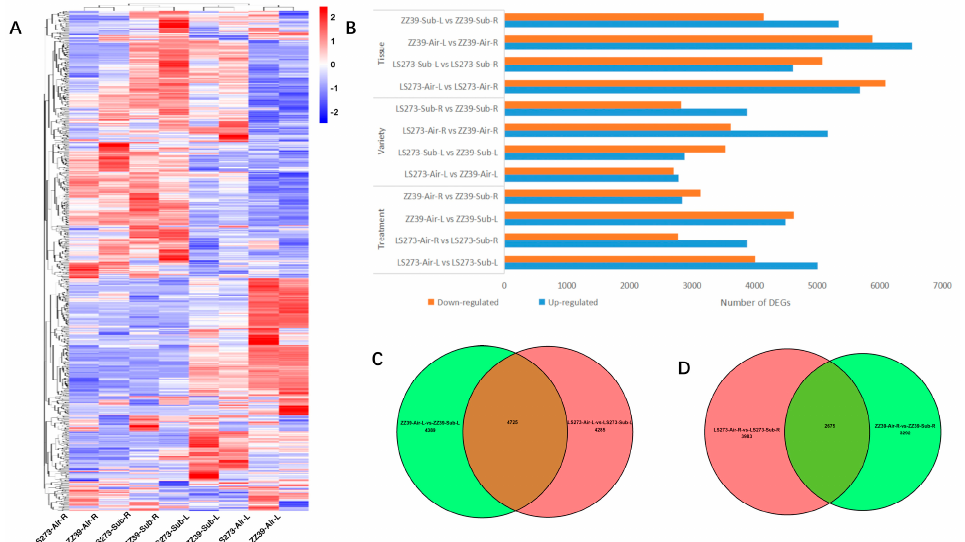
Figure 5. DEGs under flooded conditions. ( A ) Heatmap of DEGs between treatments; ( B ) number of DEGs in different tissues, varieties, and treatments; ( C ) unique and shared DEGs in shoots of LS273 and ZZ39 under flooded conditions; ( D ) unique and shared DEGs in roots of LS273 and ZZ39 under flooded conditions.